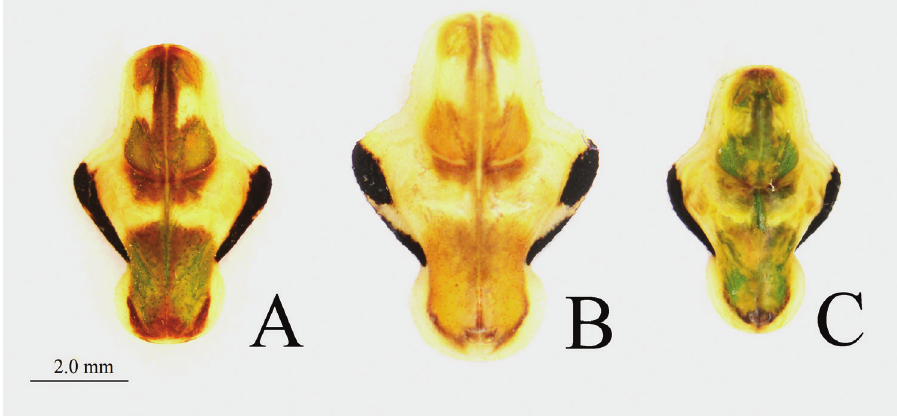
Figure 6. Pronotum of male Theopropus spp. in dorsal view A T. sinecus sinecus from Guangxi B T. xishiae sp. nov. holotype C T. sp. from